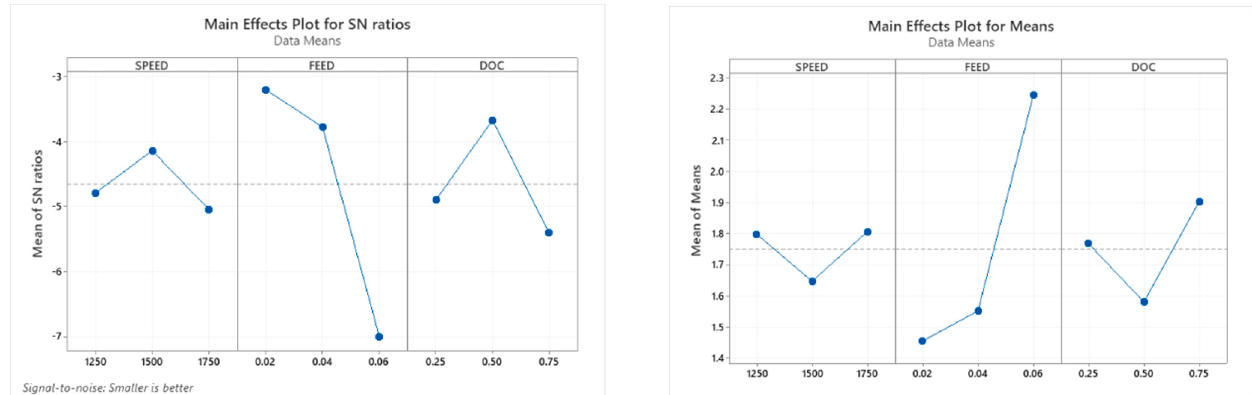
Figure 9. Highest influence plot for SN ratio and means for Ra.